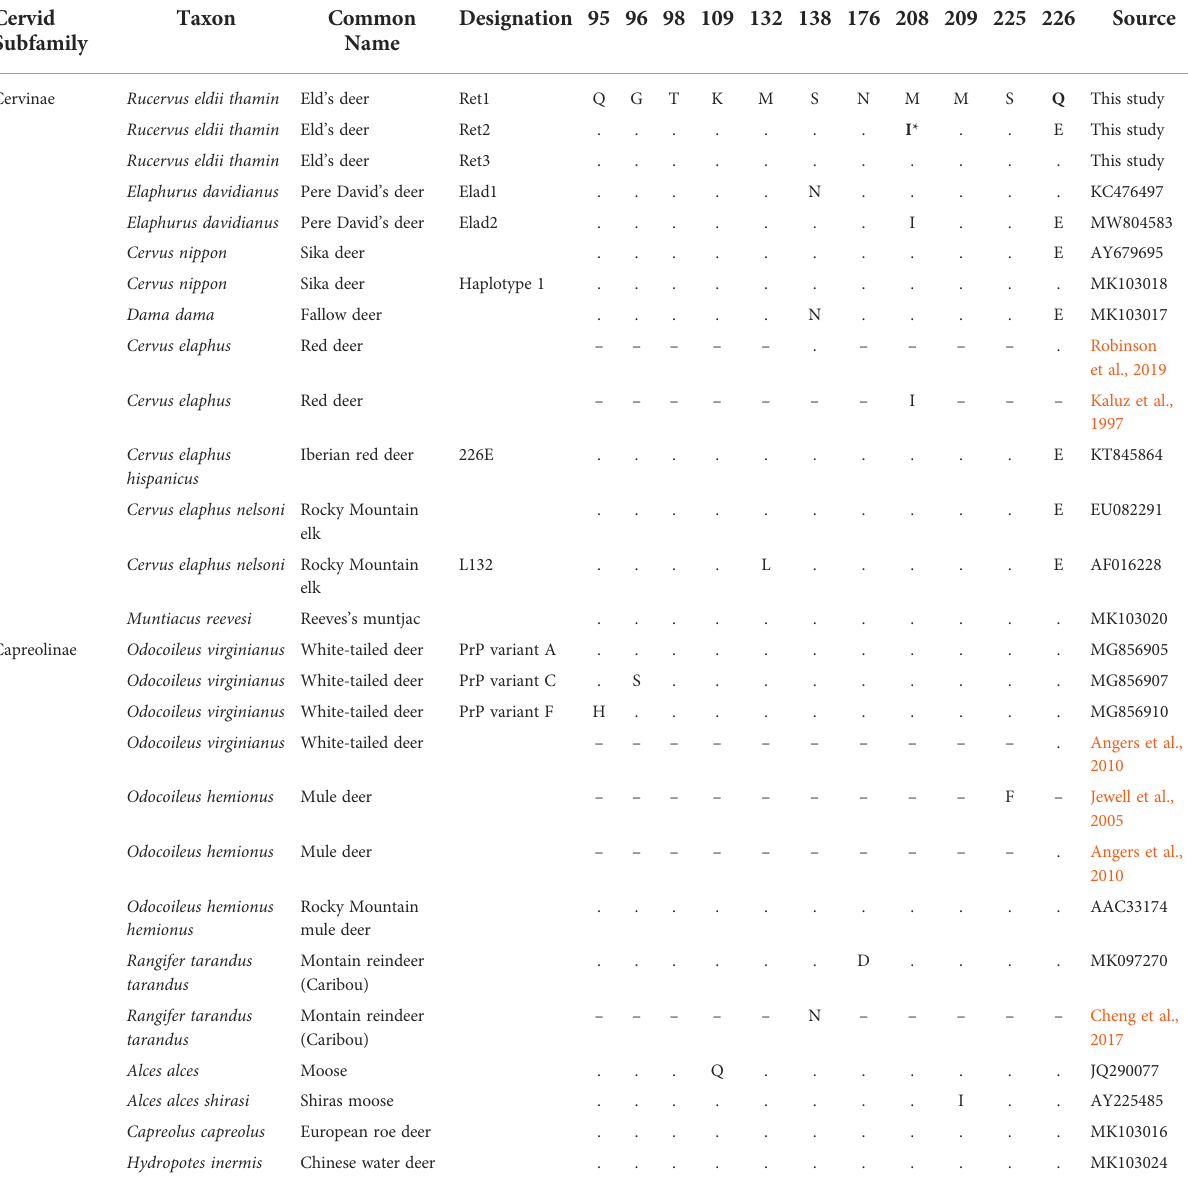
TABLE 2 PrP variation in various cervid taxa.